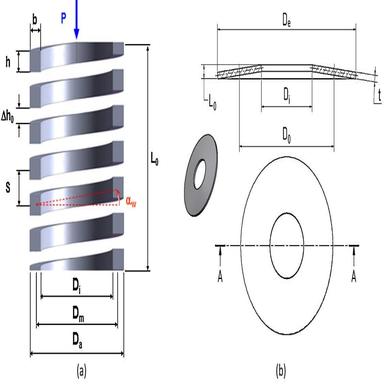
Schematic drawing showing the dimensions of the (a) helical springs: Da = 10.000 mm, Di = 7.274 mm, b = 1.363 mm, h = 2.608 mm, s = 3.608 mm, L0 = 13.000 mm, number of active coils nf = 2.880, Δh0 = 1.0 mm (redundant value), αw: coil angle (redundant), and the (b) disk springs: De = 50.12 mm, Di = 18.4 mm, L0 = 2.62 mm, t = 1.25 mm.